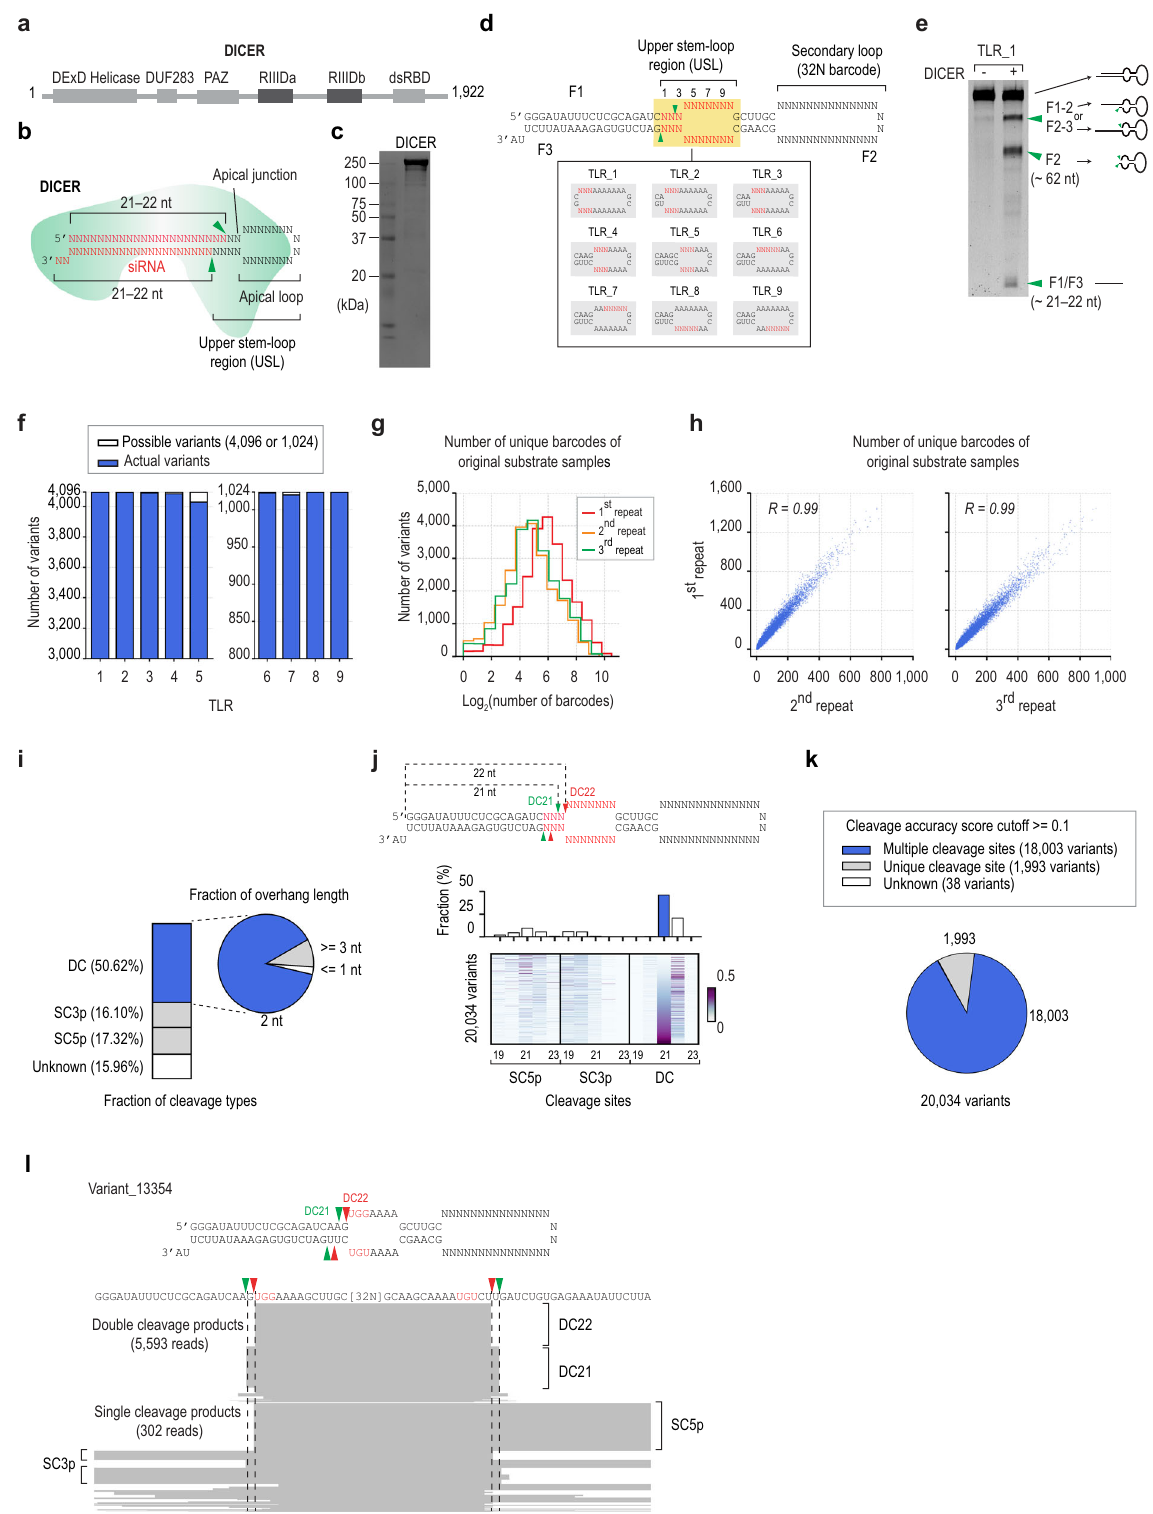
TLR_1 to TLR_5), or a 5-nt randomized single-stranded RNA (ssRNA) region on either the 5p- or 3p-strand (TLR_6 to TLR_9) (Fig. 1d). shRNA variants produced in subgroups 1 – 5 expectedly contained different base pairs, mismatches, and bulges in the upper stem region, while those generated from subgroups 6 – 9 possessed different primary sequences in the loop. We found that DICER cleaved TLR_1 and generated an siRNA (F1/F3) of NATURE COMMUNICATIONS| (2022) 13:2138